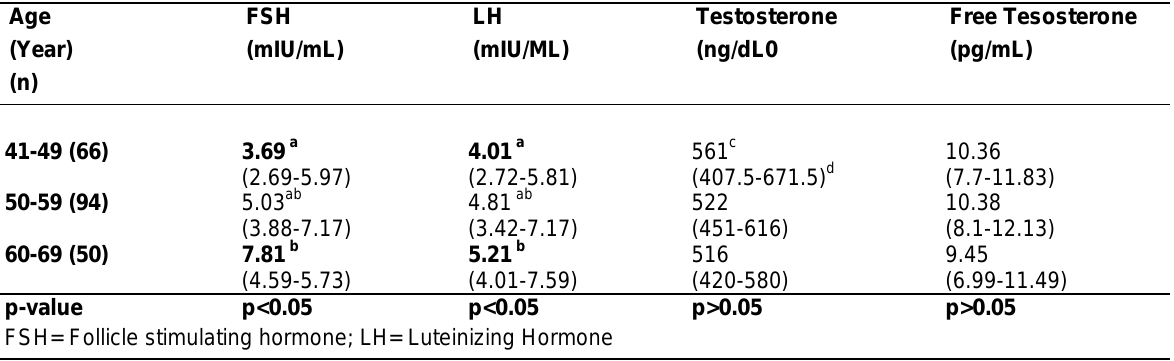
Age related changes of testosterone, free testosterone, FSH and